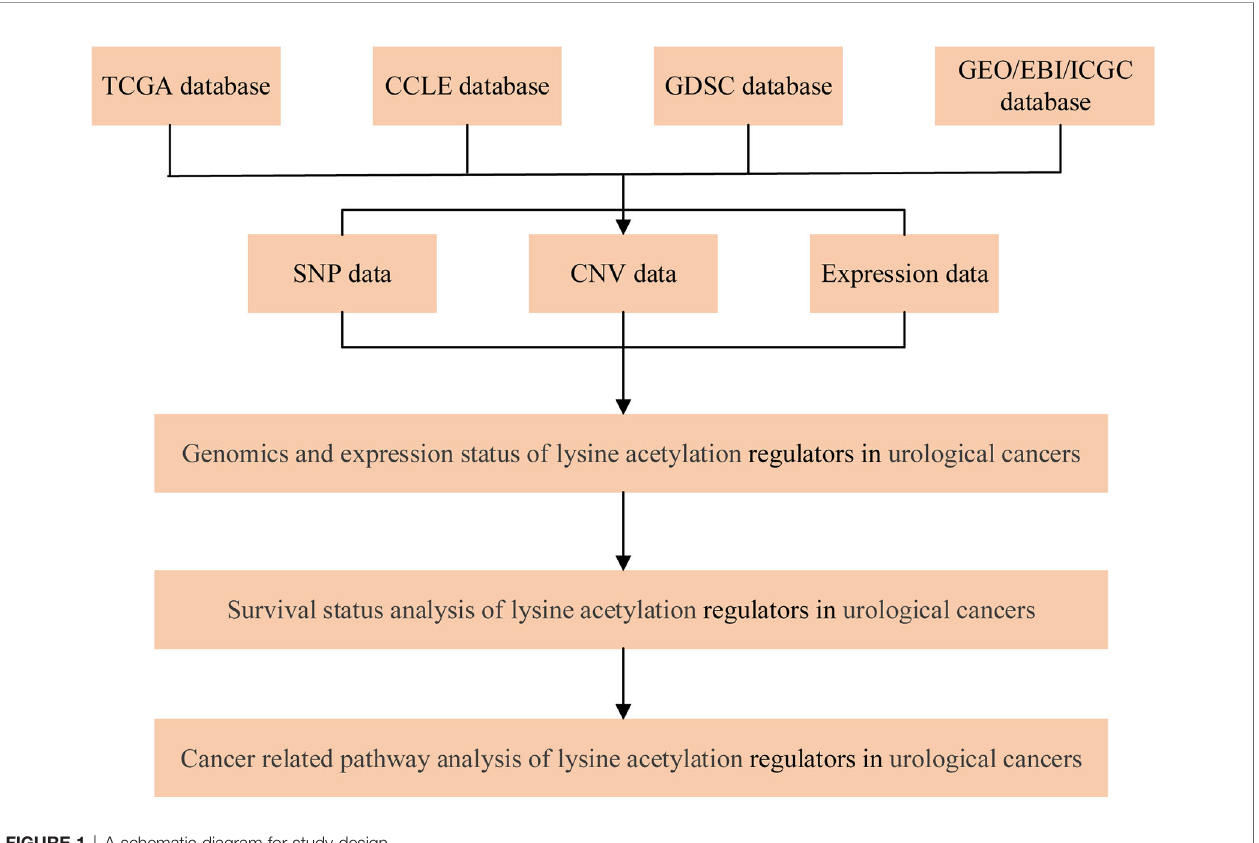
FIGURE 1 | A schematic diagram for study